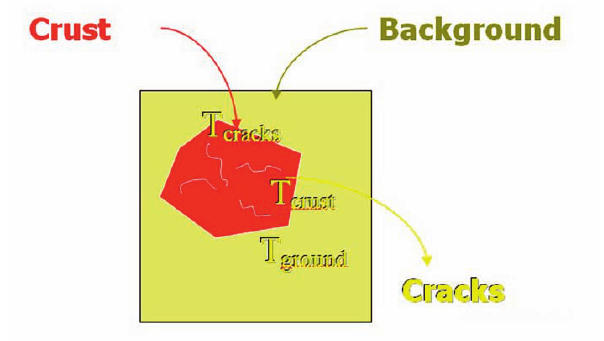
Figure 4. The three-thermal-component model. This is characterized by , crack temperature; T three distinct sub-pixel temperatures: T h temperature, and T , ground b